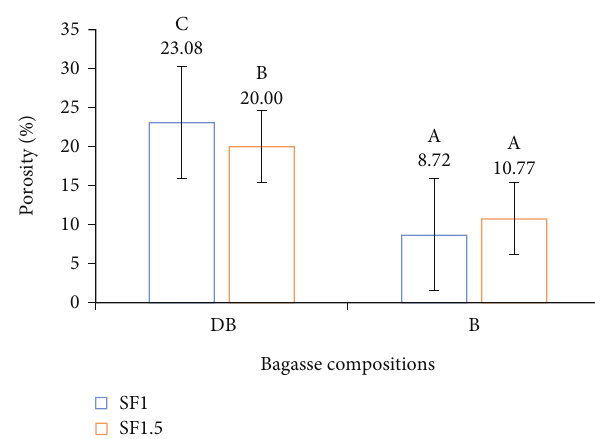
Figure 6: The interaction e ff ect of the bagasse composition of bagasse fi ber (DB) and whole bagasse (B) and addition of soybean fl our bagasse ratio 1 :1 (SF1) and 1.5:1 (SF1.5) to the porosity of biofoam cup (values followed by the same letter indicate nonsigni fi cant di ff